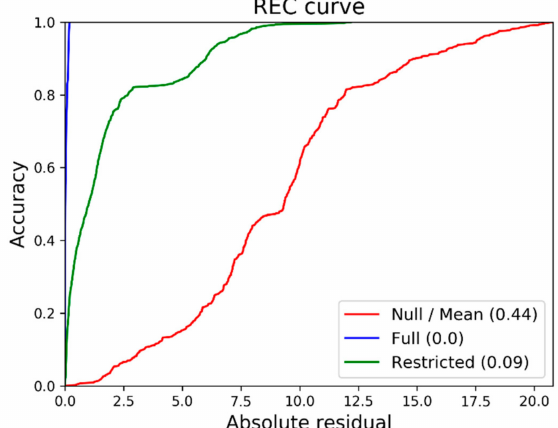
Figure 7. Regression error characteristic (REC) curve for the heating load full restricted and null (Mean) models with h = ω =